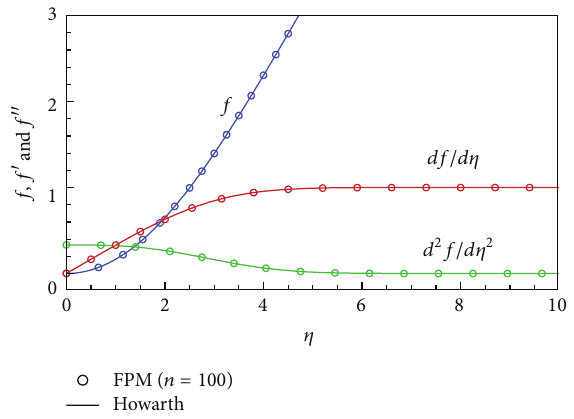
Figure 3: Comparison of FPM result ( 𝜆 = 1/5 , 𝑛 = 100 ) with Howarth’s numerical result.